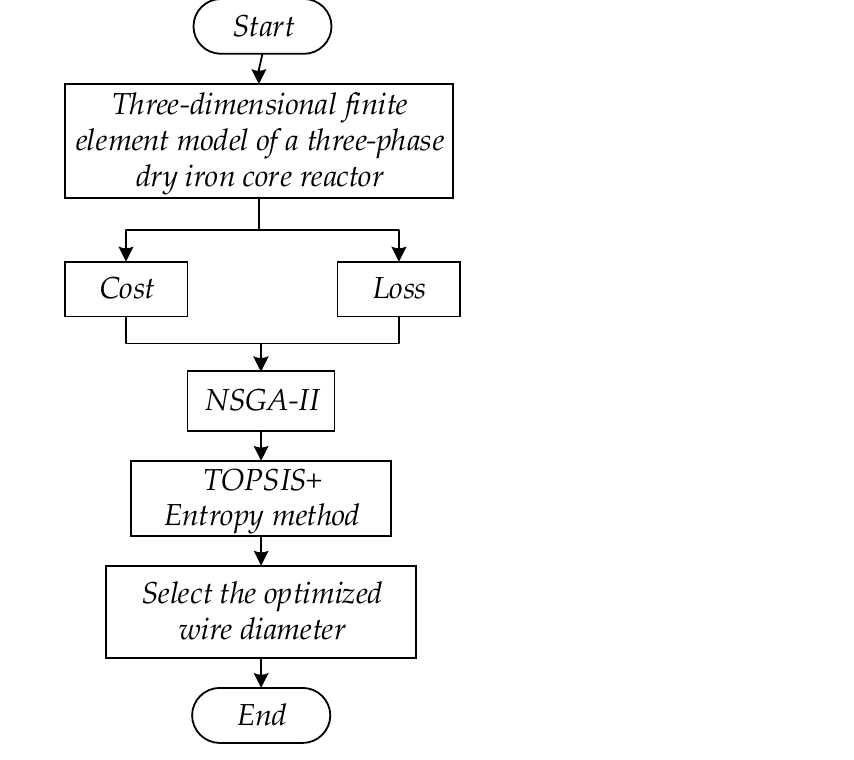
Figure 4. Dry iron core reactor optimization design process.